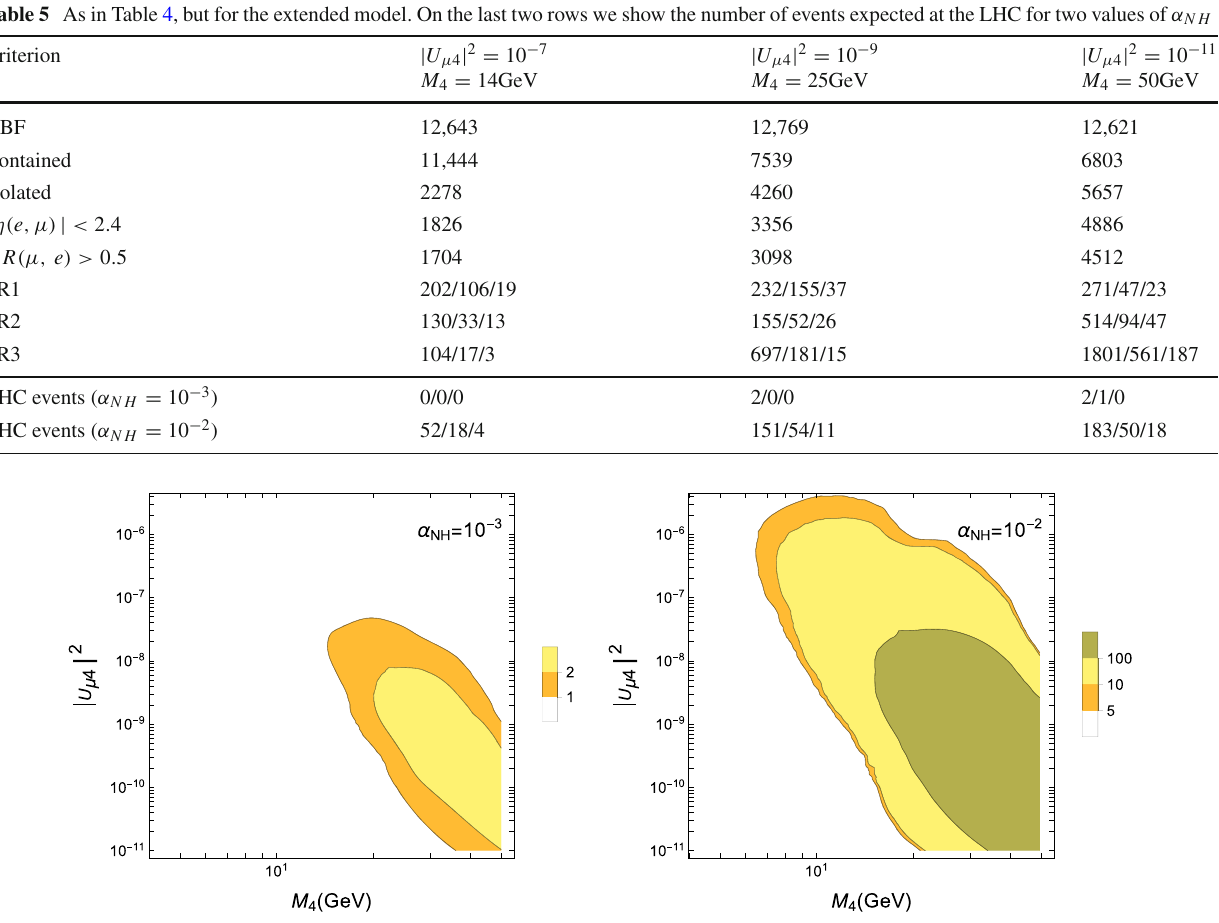
Fig. 4 Number of displaced dilepton events at the LHC, for the extended model. Only loose p T cuts are applied